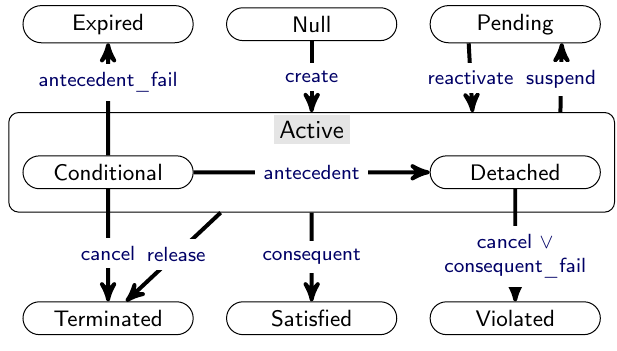
Figure 1. Commitment life cycle